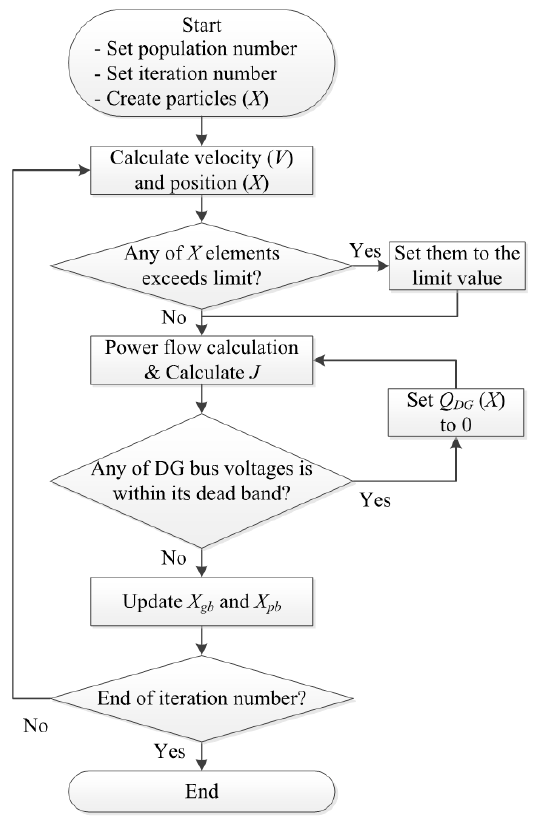
Figure 3. Flow chart of the algorithm.